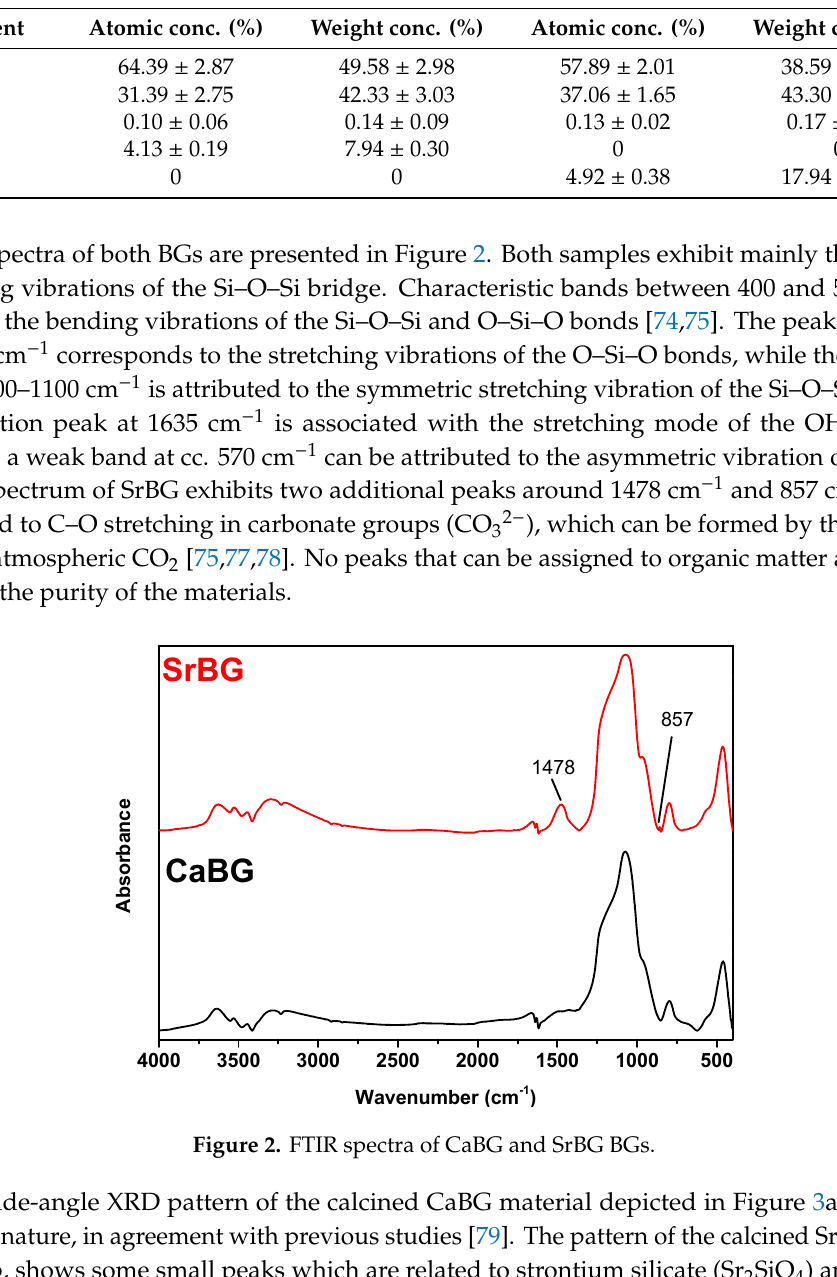
Table 1. EDX elemental analysis of CaBG and SrBG (% atomic and weight concentrations, n = 3).